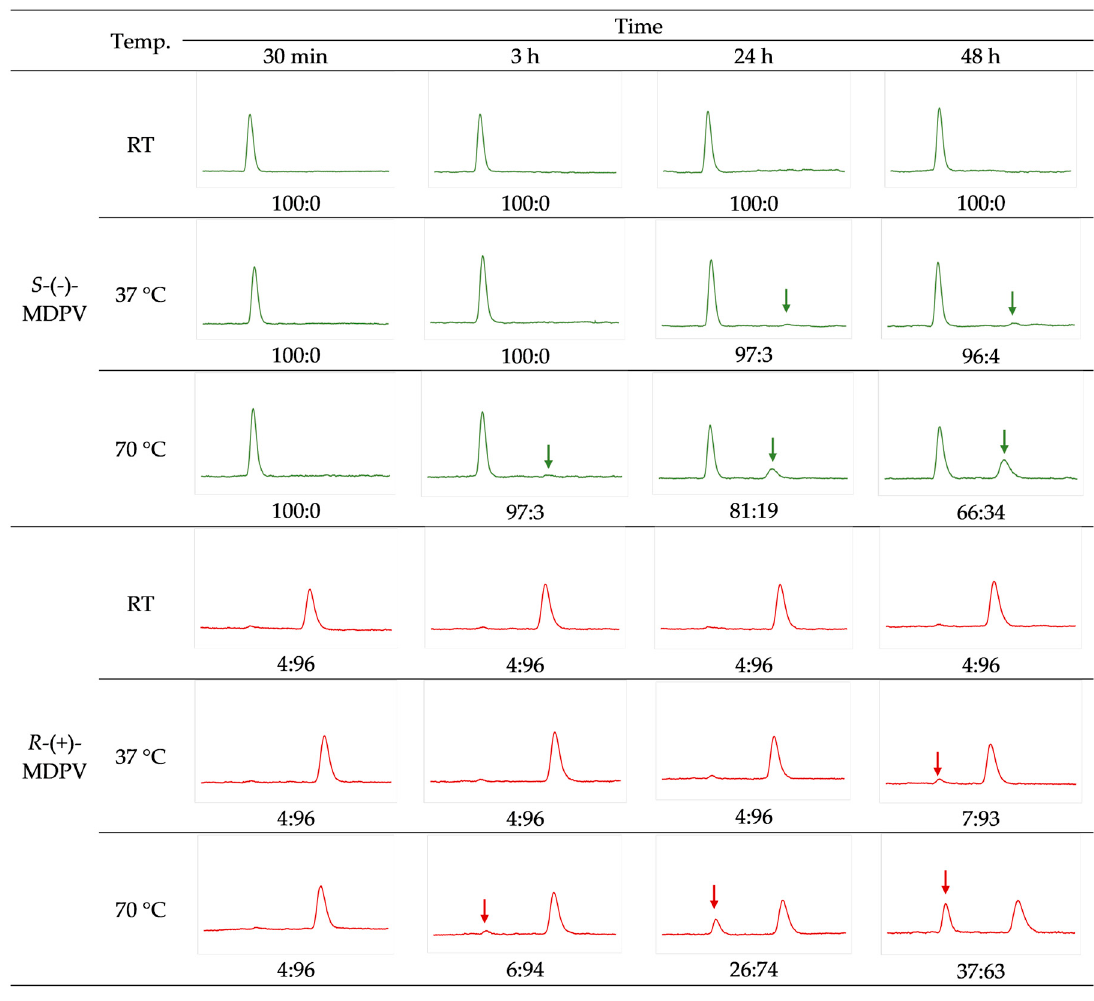
Figure 7. Chromatograms from the racemization study after exposing the enantiomers to different temperatures (RT, 37 ◦ C, and 70 ◦ C), in the presence of DIPEA for 48 h, and respective e.r. values. While for R -(+)-MDPV in the absence of DIPEA, small changes in the e.r. were observed after 48 h at RT and 24 h at 37 ◦ C, in the presence of 0.1% DIPEA, no signs of racemization were observed. On the other hand, signs of racemization were observed in this case after 3 h at 70 ◦ C, with a change in the e.r. from 4:96 to 6:94. Moreover,